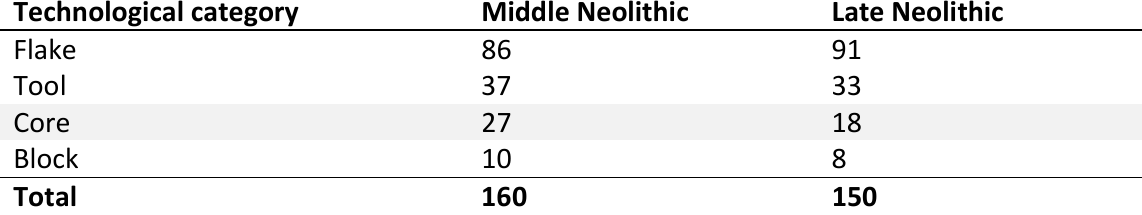
Table 3. Broad technological category of lithic industry per chronological phase.